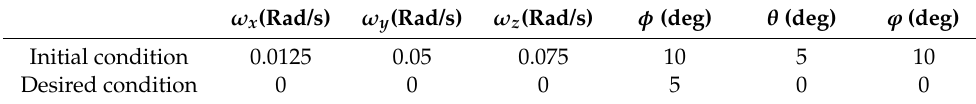
Table 2. Sample initial condition (this initial condition is not in the training